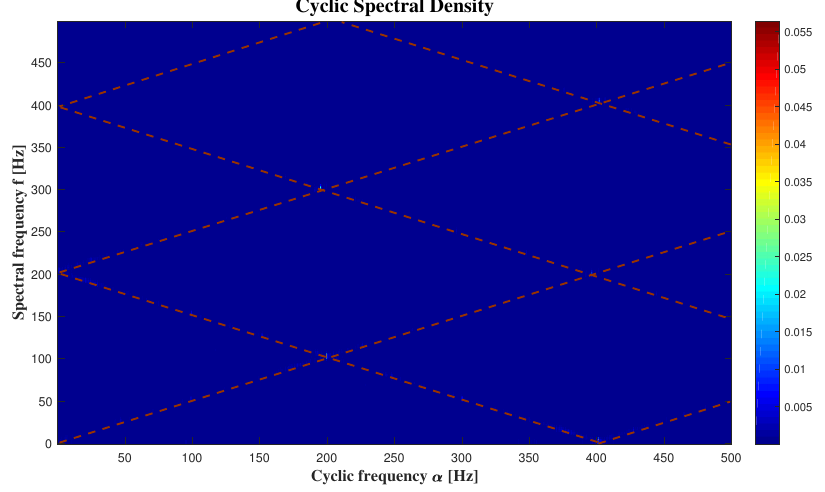
Figure 7. The cyclic spectral